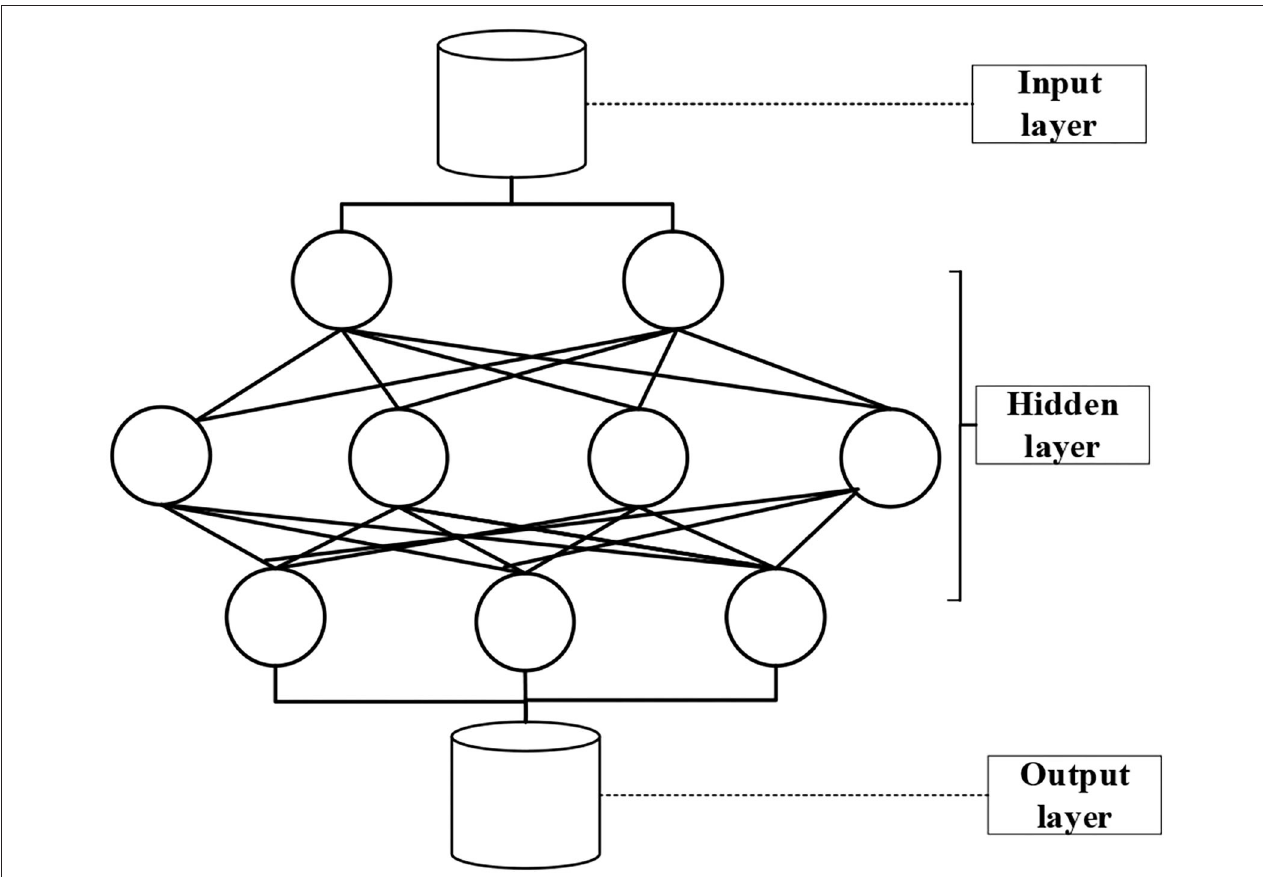
FIGURE 3 | The basic structure of a three-layered